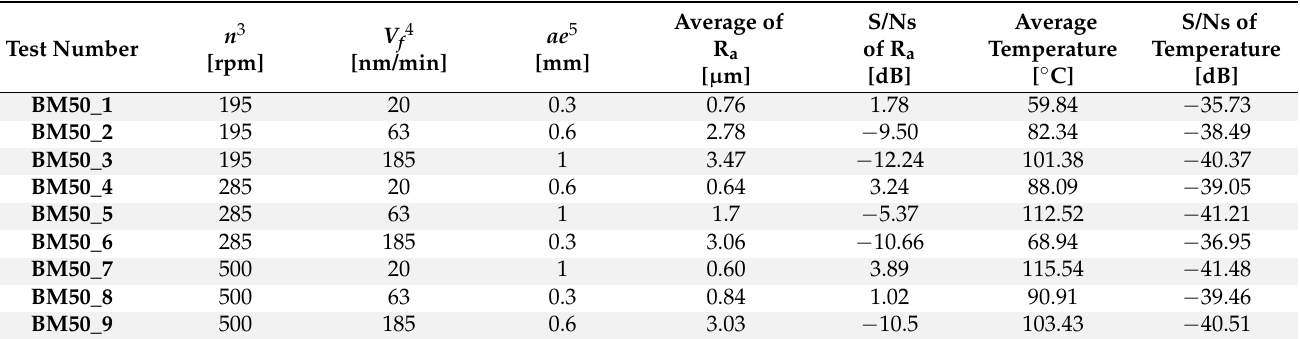
Table 7. Average surface roughness, average chip temperature, and S/Ns ratio with Balis Mafcool 51 (50